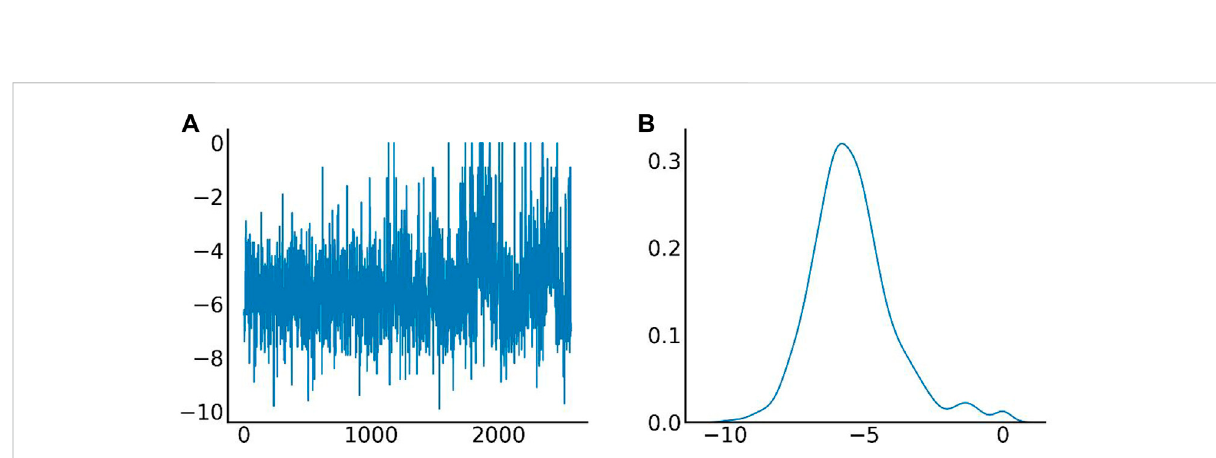
FIGURE 5 Differentaminoacidbindingmodes. (A) TheX-axisrepresentstheserial numberofFDA-approveddrugs,andthe Y -axisrepresentsthedocking fraction (unit: kcal/mol); (B) Distribution of docking fractions. The horizontal coordinate represents the docking fraction (unit: kcal/mol), and the vertical coordinate represents the distribution